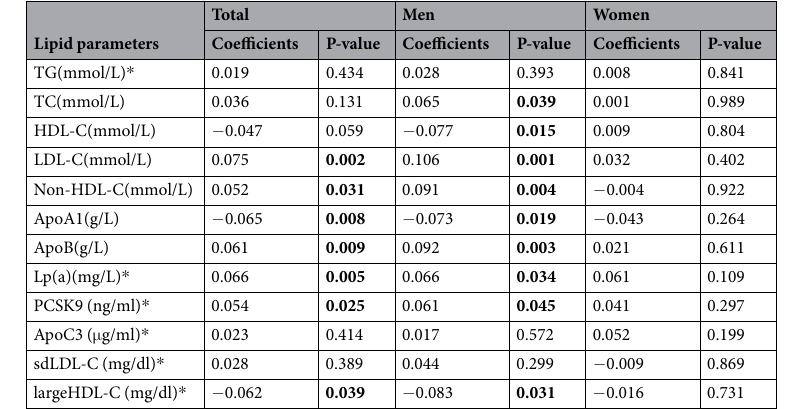
Table 2. Associations of lipid biomarkers with coronary severity using linear regression analysis. Multiple linear regression analyses were performed and standard coefficients were showed with adjustment for age, gender, hypertension, HbA1c, current smoking and hs-CRP. The bold values indicated statistical significance and were bolded to improve the readability of the table. * Log-transformed data. Abbreviations as Table